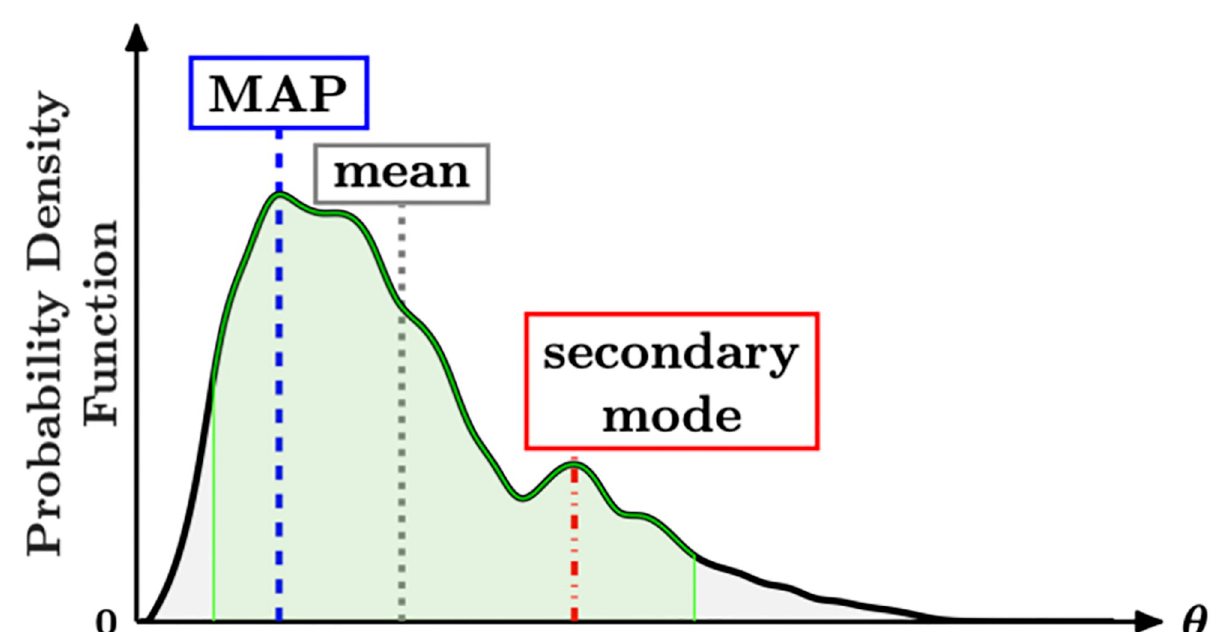
Fig 2. Examples of point estimates depicted on an arbitrary probability density function (black line). The MAP (maximum a posteriori ) point is located at the most probable point (blue dashed line). The long tail of the distribution shifts the mean (gray dotted line) away from the MAP point. Secondary modes (red dashed-dotted line) can effect the quality of a point estimate. Additionally, the green shaded region highlights the 95% credible interval, the region between the 2.5th and 97.5th percentiles, that is used to capture the uncertainty in an estimate.